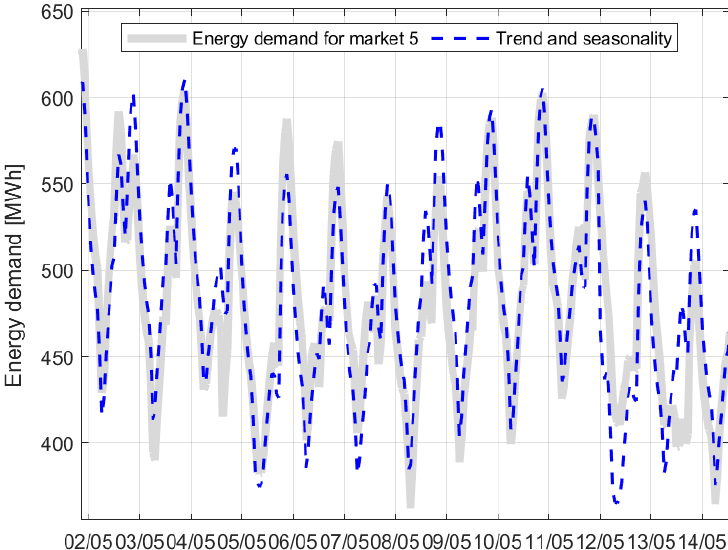
Figure 7. Daily energy demand for Market 5 between 2–14 May 2018.